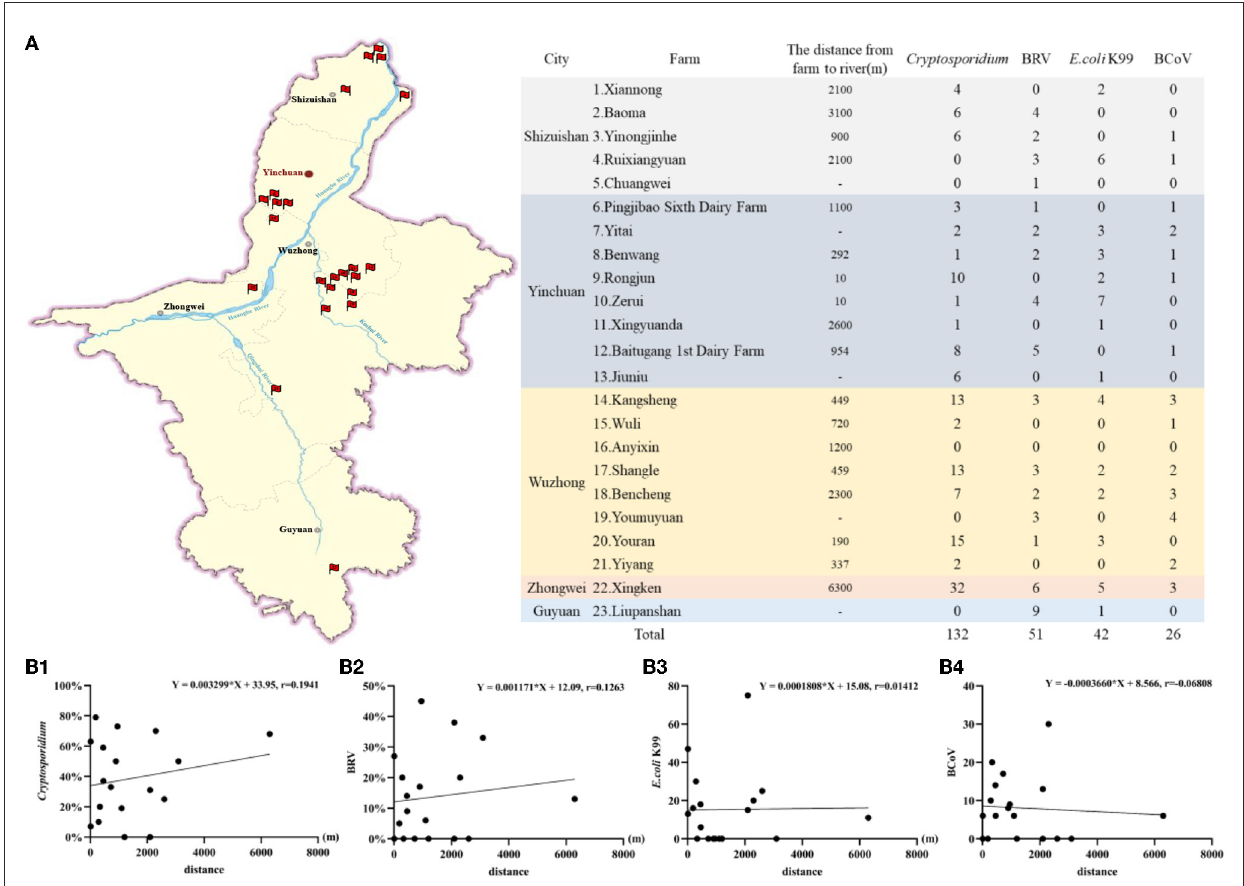
FIGURE7 The correlation analysis of main pathogens causing calf diarrhea and river distribution. (A) The number of Cryptosporidium , BRV, E. coli K99, and BCoV detected in cattle farms and distribution of sampling cattle farms and rivers. (B1) The correlation between the Cryptosporidium detection rate and the distance from cattle farm to river. (B2) The correlation between the BRV detection rate and the distance from cattle farm to river. (B3) The correlation between the E.coli K99 detection rate and the distance from cattle farm to river. (B4) The correlation between the BCoV detection rate and the distance from cattle farm to